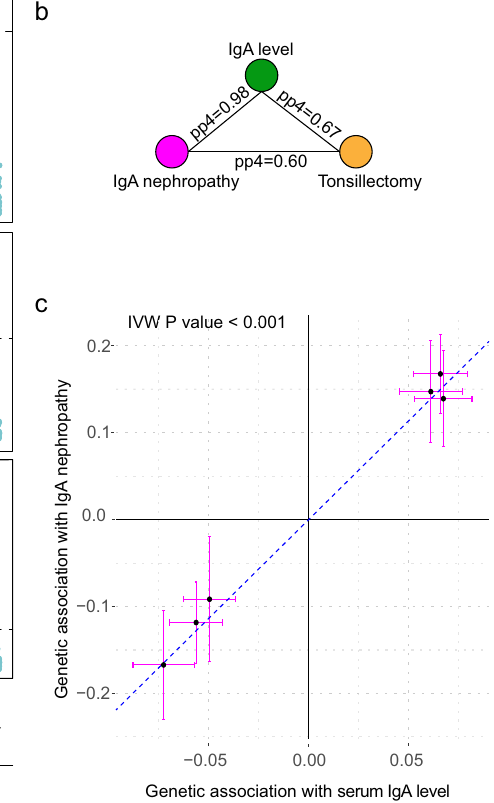
IgAlevel(GWAS N =41,263)asanexposure,IgAnephropathy(GWAS N =38,897)as an outcome, and co-localizing loci as instruments. The error bars correspond to 95%con fi denceintervalsfortheeffectsize.The x and y axisrepresenteffectsizesof the genetic variants associated with the exposure and outcome, respectively. P -value corresponds to the two-sided inverse variance weighted (IVW) Mendelian Randomization